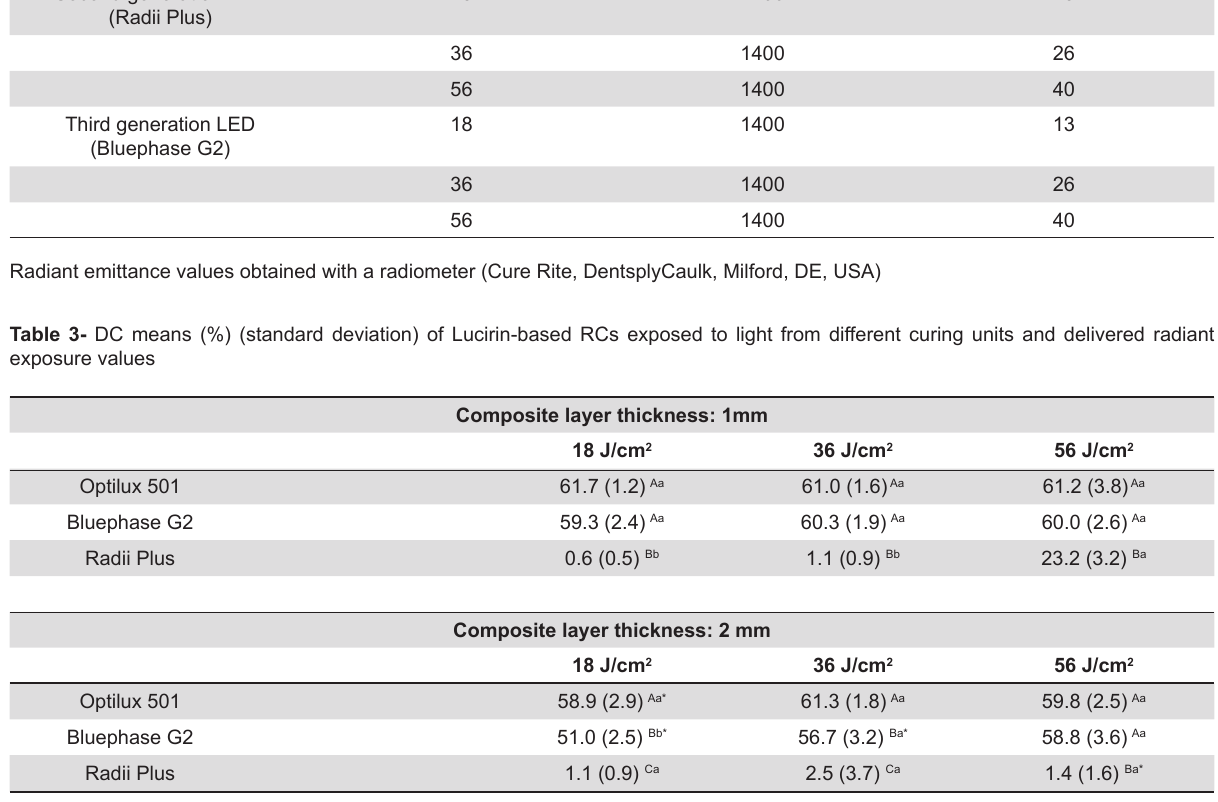
Means followed by different letters (lower case - within row; upper case - within column) are significantly different for each composite layer thickness. Differences in DC values between RC thickness is followed by asterisk (p=0.05)